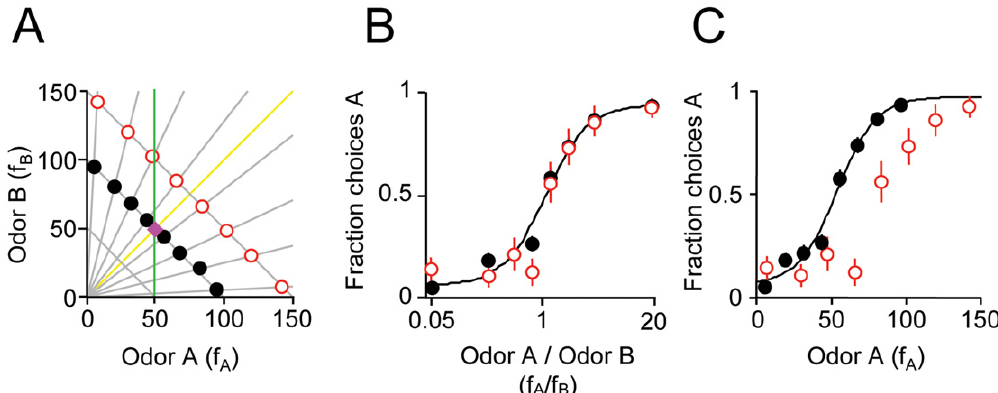
Figure 2. Odor mixture discrimination by component ratio generalizes to higher concentration probe stimuli. (A) Training stimuli (black fi lled circles) had + f = 100. Test stimuli (red circles) were chosen such that f + f = 150. The training reward boundary is indicated by the magenta diamond. See Figure 1A f A B A B for details. (B) Choices of one rat on training stimuli and test stimuli with higher concentration. The independent variable is the ratio f points are not visible because they are hidden behind the corresponding test data points. (C) Choices of one rat on training and test stimuli. The independent . variable is the single component f A